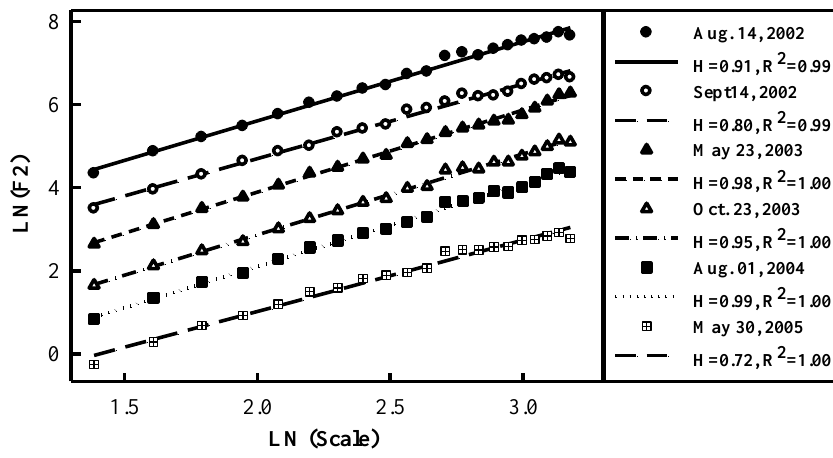
Fig. 3 640 Fig. 3. Double – logarithmic plots of the standard fluctuation functions fitted to linear equation. In order to avoid overlapping of the plots (and hence difficulty in comparisons) a constant values have been added to the fluctuation functions of each series. “Scale” refers to a period (cycles) in meters.